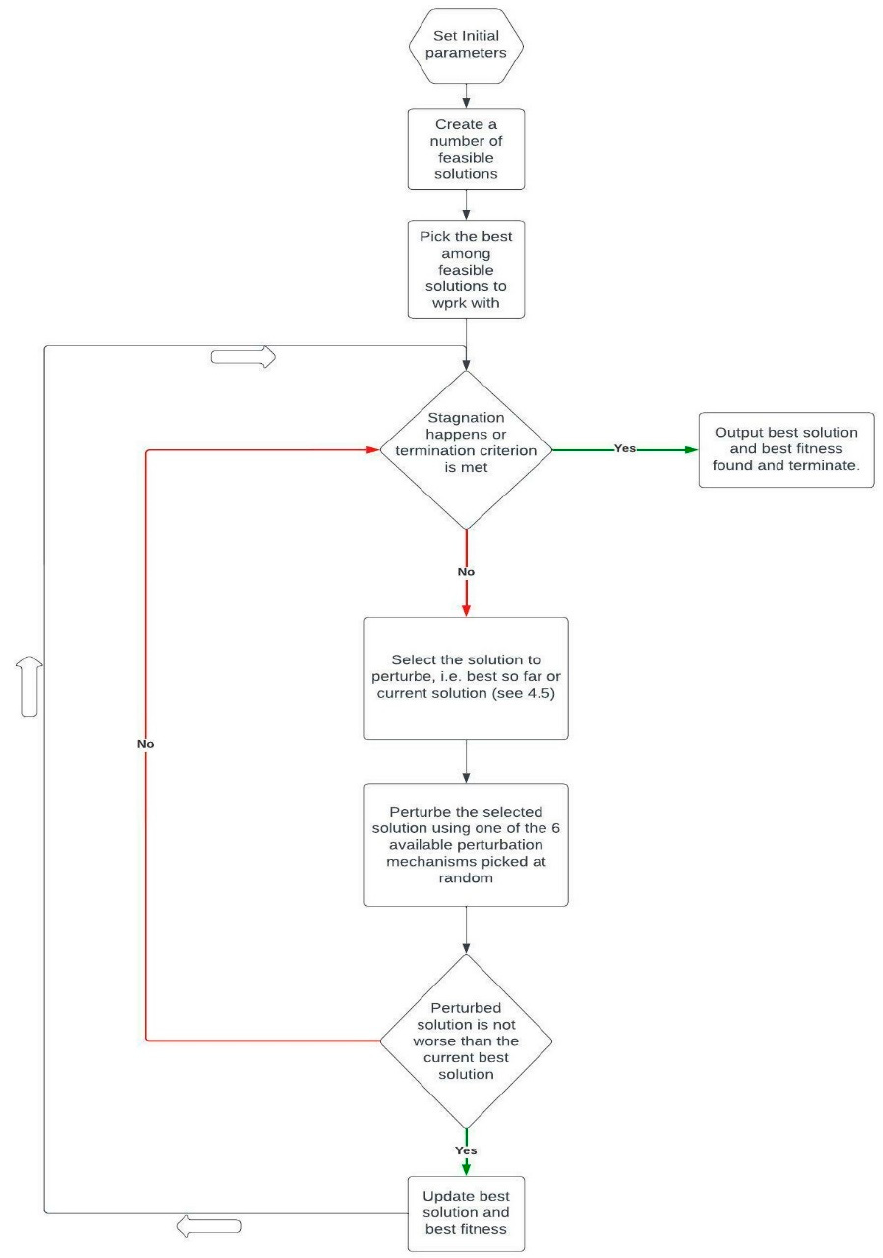
Figure 2. Algorithm pseudocode.